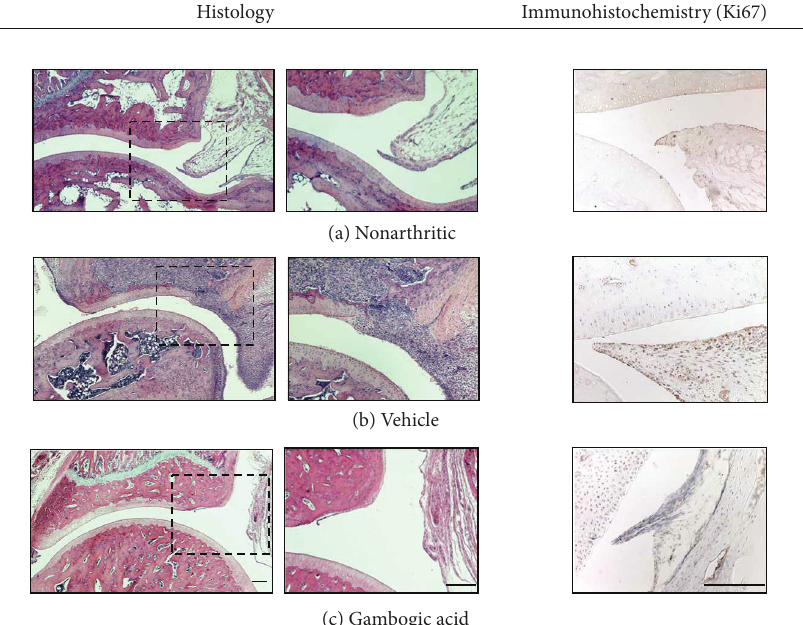
Figure 5: Histological and immunohistochemical evaluation of joints after 15 days of treatment. Nonarthritic control (a), vehicle-treated (b), and gambogic acid in the early treated group (c) AIA rats (magnification of 50x and 100x in histological images and a magnification of 200x in immunohistochemical images). Notice that gambogic acid has completely prevented immune cellular infiltration and proliferation, as well as bone invasion. Bars: 100 𝜇